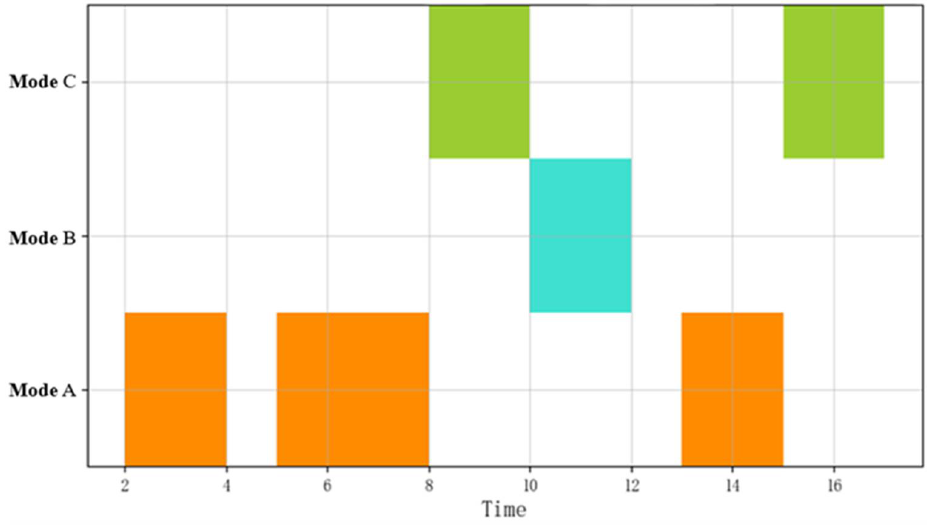
Figure 4 . Visualization of the potential sequential combinations of event flows.